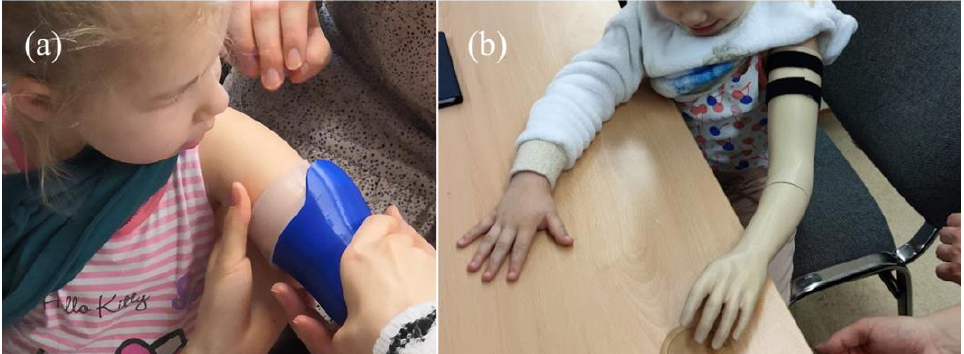
Figure 18. Testing of the sockets with the patient: ( a ) VAC socket and ( b ) VEL socket (in assembly with a complete prosthesis).